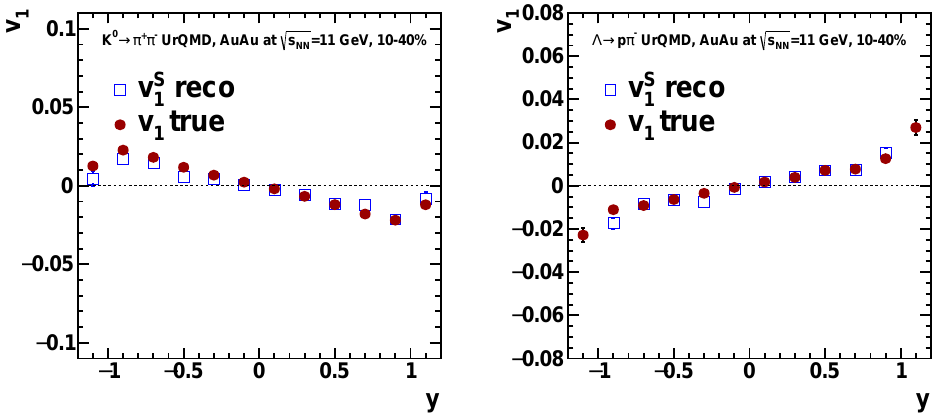
Figure 11. Rapidity y dependence of directed v 1 flow of of K 0 ( left ) and Λ ( right ) particles for 10–40% S √ s NN = 11 GeV: open symbols represent the “true” v 2 results and filled central Au + Au collisions at symbols the “reco” v 2 results.